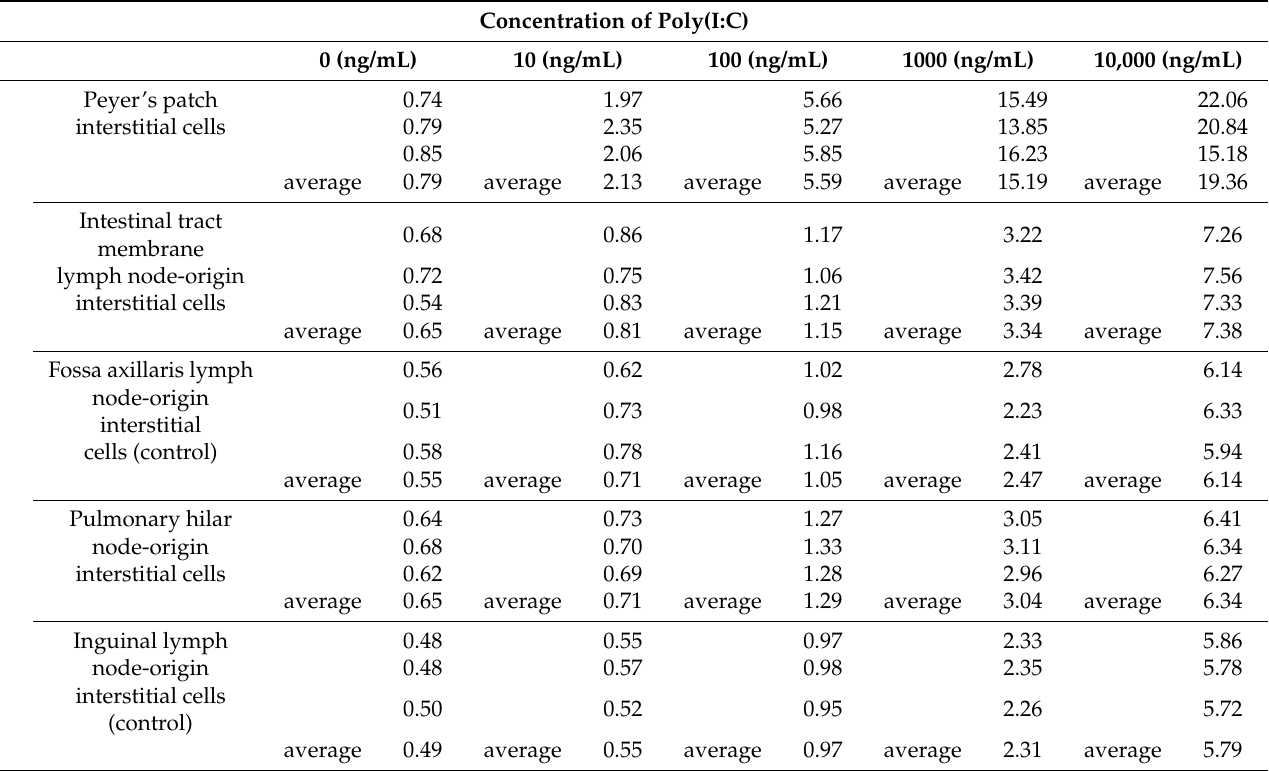
Table 4. Amounts of IFN β secreted from various lymph node interstitial cells after addition of different concentrations of